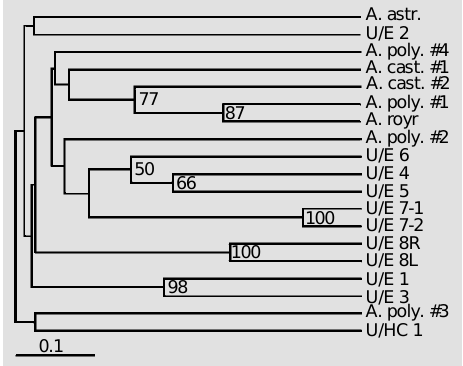
Figure 4 - Unrooted UPGMA phenogram based on RAPD pro- files of 19 Acanthamoeba iso- lates obtained with primers 606, 688 and 694. For abbreviations, see legend to Figure 2. The num- bers at the nodes represent bootstrap values for a hundred